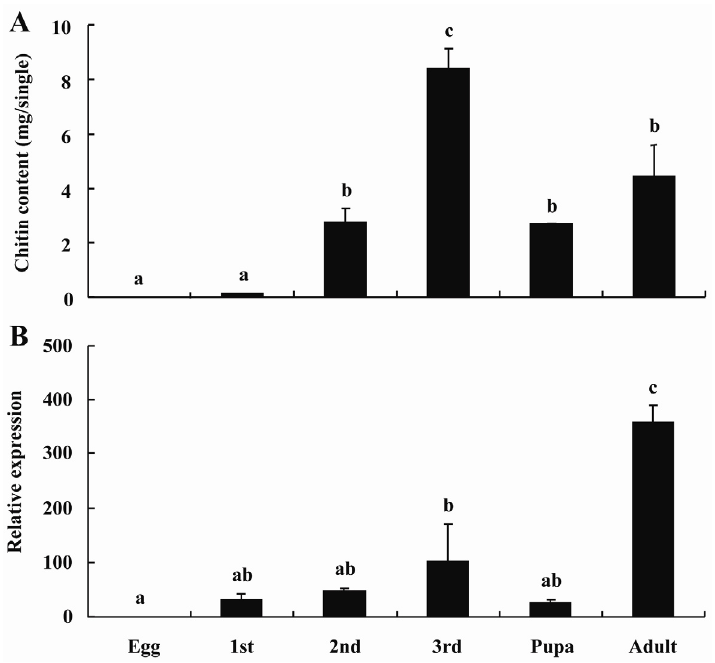
Figure 4. ( A ) Developmental changes of total chitin content and ( B ) mRNA levels of BdCHS2 in Bactrocera dorsalis . α -Tubulin was used as an internal reference gene. The relative expression was calculated based on the value of the lowest expression, which was ascribed an arbitrary value of 1. Data are means ± SE of three biological replications. Different letters above each bar indicate statistically significant difference by ANOVA followed by the Duncan’s multiple range test ( p <